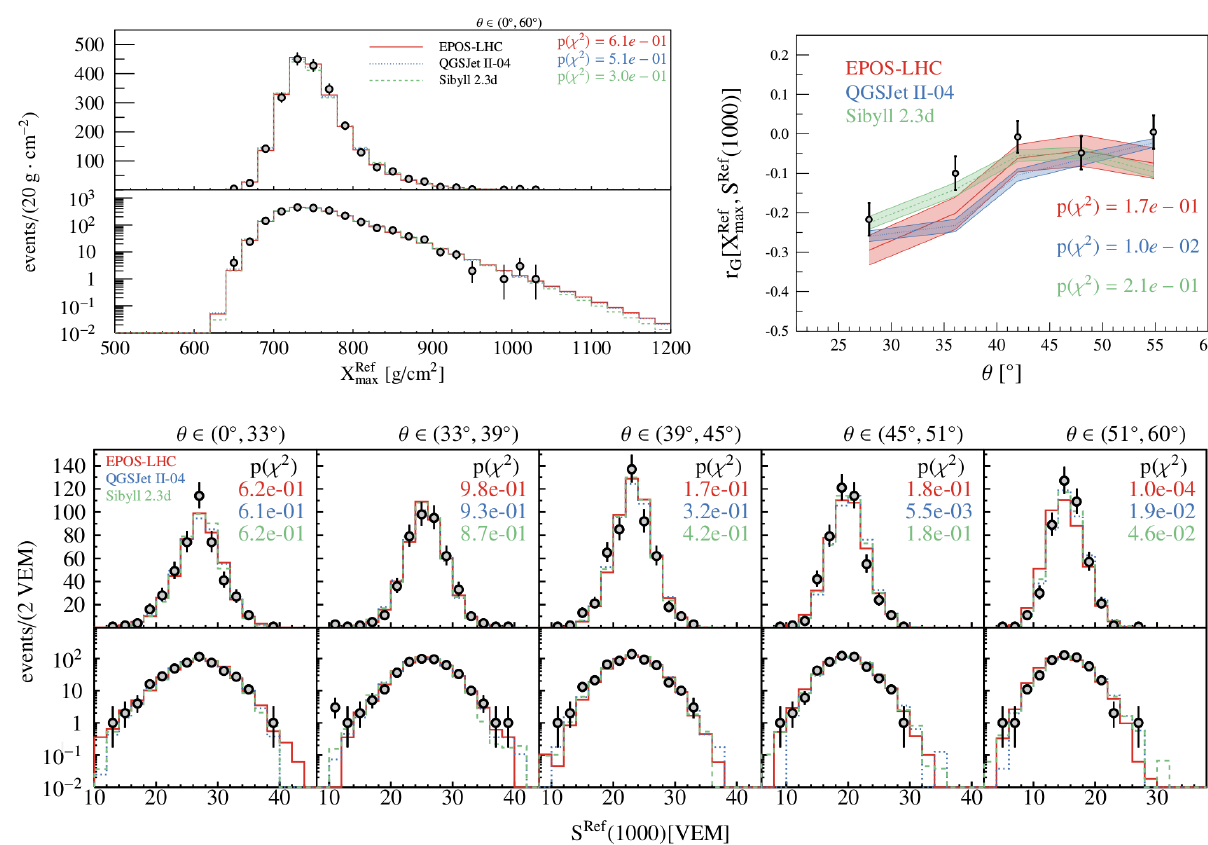
Figure 6: Composition fits with a freedom in R Had and ∆ X max , see caption of Fig. 4.